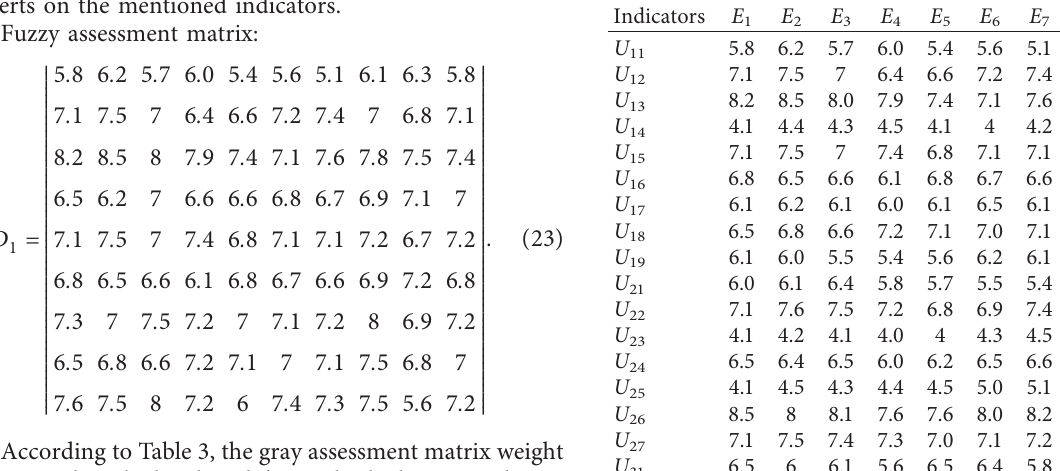
Table 8: Risk index